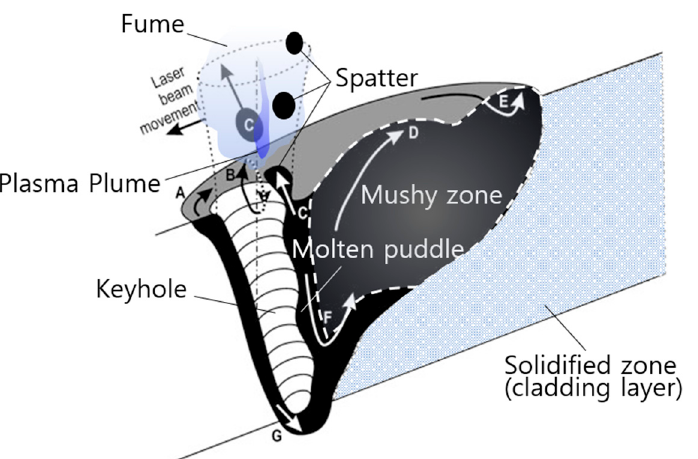
Figure 5. Modified schematic diagram of Kaplan’s and Katayama’s illustration, depicting the evap- oration products formation by laser [70,73] ((Reproduced with permission from ref. [73], copyright (2017), Springer Nature)).